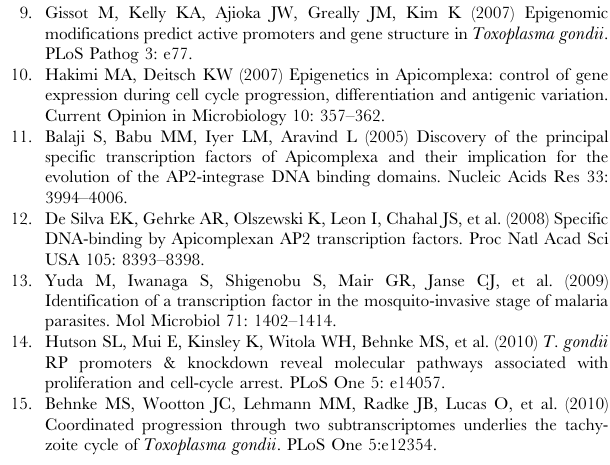
Figure S2 The first site-directed mutagenesis reaction of the putative TgMag1 promoter resulting in the disruption of a single TTTCT motif within the TTTTTCTTCTC motif of the promoter to ATCGA TCTC to give D 1 Tg Mag1 plasmid, which was used in promoter activity assays. Figure S3 The first mutagenized vector described above ( D 1 Tg Mag1) was subjected to a second round of mutagenesis to generate ATCGAGCGC ( D 2 Tg Mag2). This mutant promoter was also cloned upstream of the reporter luciferase construct for promoter activity assays. Figure S4 Targeted deletion of the ENO1 gene. A) Strategy for deleting the TgENO1 gene in the Pru D ku80 D hxgprt strain using MPA selection. PCR1-4, locations of PCR products used to verify the genotype (not to scale; see Table S2). B) Validation of TgENO1 -deleted clones based on the products of PCR1 (655 bp), PCR2 (356 bp), PCR3 (1,181 bp), and PCR4 (1,304 bp). Top panel: 12 randomly selected MPA-resistant clones were assayed by PCR1 and PCR2 (lanes 1–12). Lane 13 corresponds to parental Pru D ku80 DNA assayed by PCR1 and PCR2. Lane 14, no- template control. Clones 1–12 exhibited perfect deletion of the TgENO1 gene. Bottom panel: clones 1–6 with deletion of TgENO1 were assayed by PCR4 (lanes 1–6) and PCR3 (lanes 11–16). Parental Pru D ku80 DNA was also assayed by PCR4 (lane 7) and PCR3 (lane 17). Lanes 8 and 18 show no-template controls. DNA size ladder is shown in lanes 9 and 15. Clones 1–6 were validated as TgENO1 knockouts with the genotype Pru D ku80 D T- geno1 . C) One knockout mutant was checked for perfect allelic integration and double homologous recombination using two primers (forward and reverse) specific for the open reading frame of TgENO1 and two other primers in the ORF (reverse) and the TgENO1 promoter (forward). Superoxide dismutase (SOD) was used as a PCR control. The sequences of the primers are indicated in Table S3. All in vitro and in vivo phenotypic studies were performed using this TgENO1 knockout mutant. Table S1 Primers used in this study. The names and sequences of all primers used in this study are listed together with